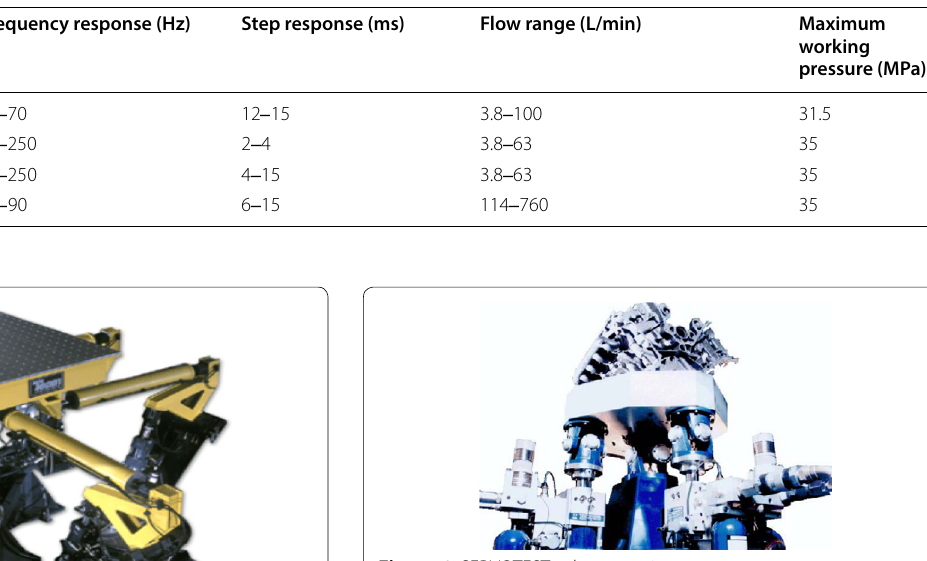
Figure 6 SERVOTEST exhaust testing